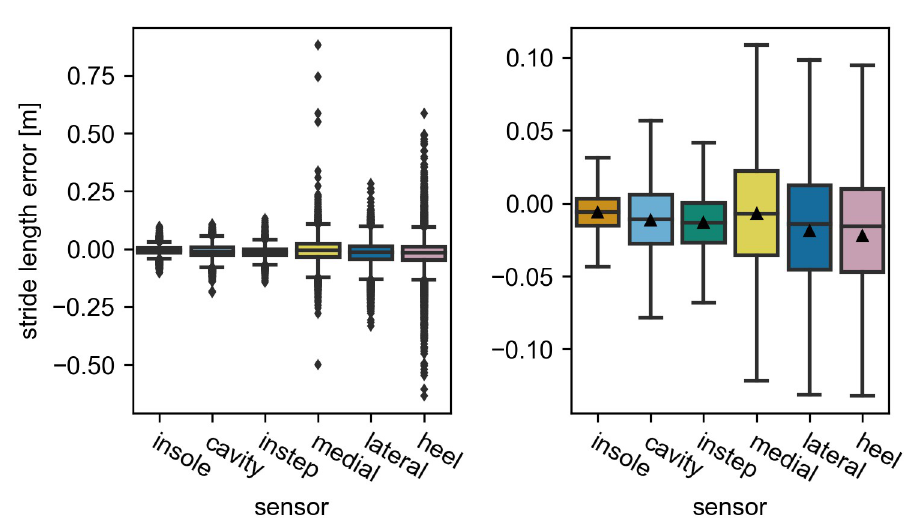
Fig 5. The stride length error of each sensor position over all strides. The image on the left shows all straight strides. The image on the right has all outliers ( > Q 3 + 1.5 IQR and < Q 1 − 1.5 IQR ) removed for visual clarity. Values larger than 0 indicate an overestimation by the IMU. The black triangles mark the means of the distributions. They are omitted in the left image for visual